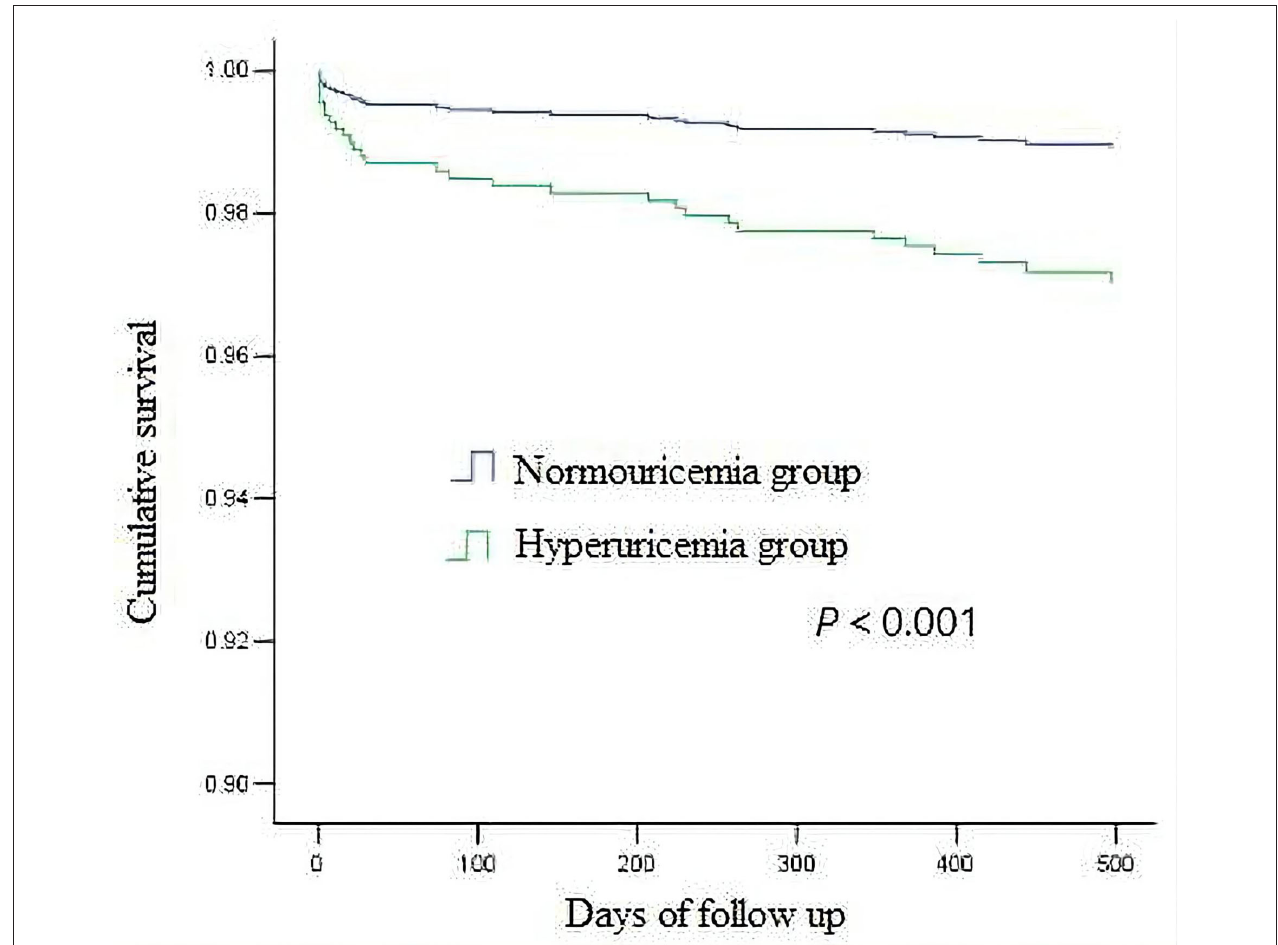
FIGURE 1 | The Kaplan-Meier curve for cumulative